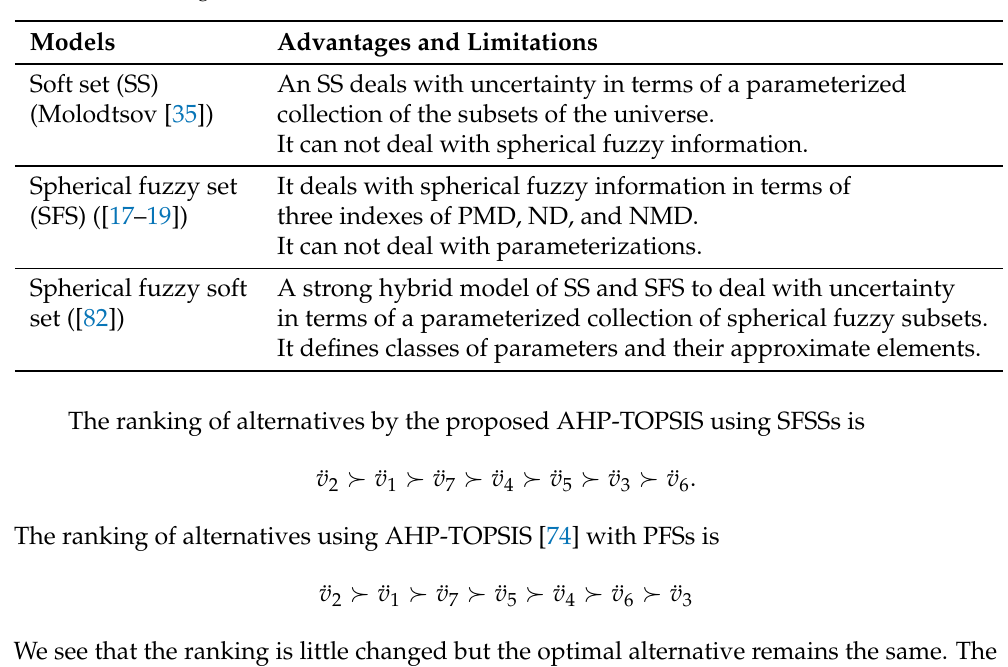
Table 21. Advantage of